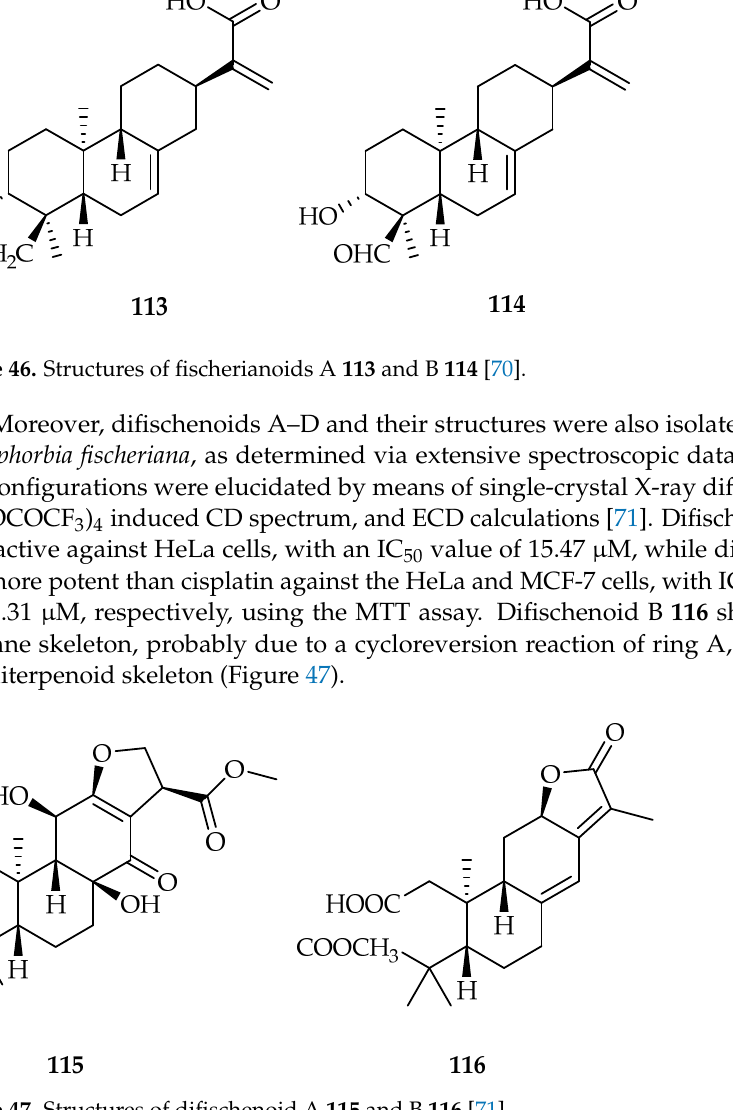
29 of 76 Figure 45. Structures of euphonoids A−D 108–111 [68] and fischeriabietane A 112 [68,69]. Fischerianoids A–C were also isolated and identified from the ethyl acetate extracts